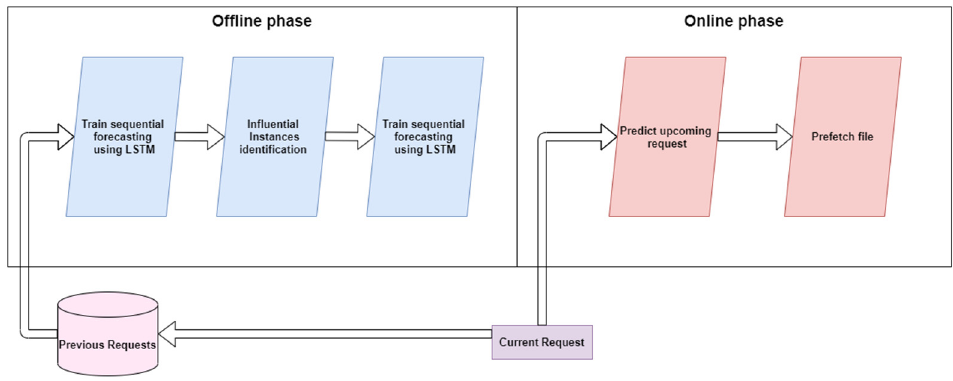
Figure 2. The prefetch scheme’s overall workflow, including influential instances.